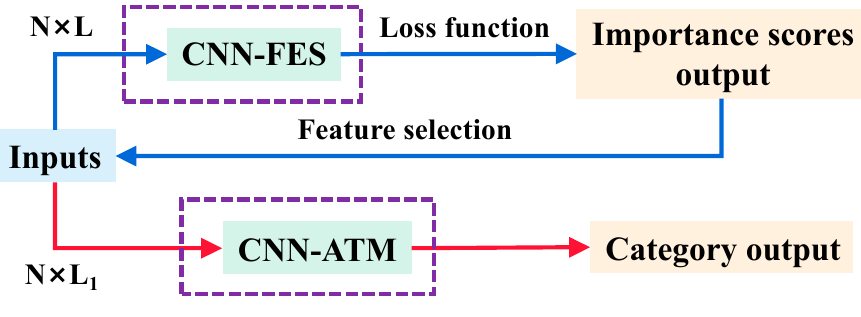
Figure 4. CNN network processing flow.